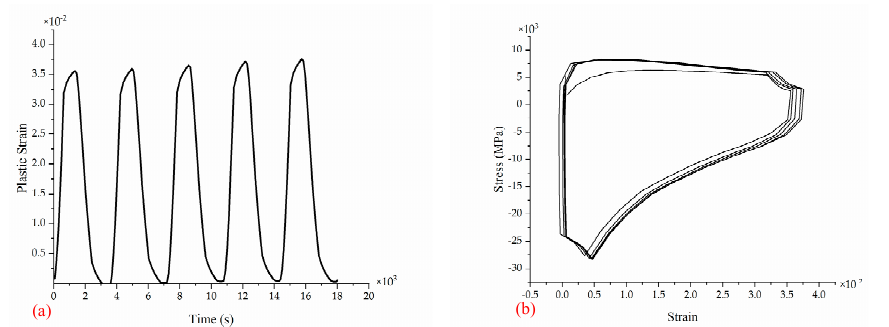
Figure 9. The mechanic response profile: ( a ) the plastic strain curves of the dangerous solder node, ( b ) the stress-strain hysteresis loop of the dangerous solder node.